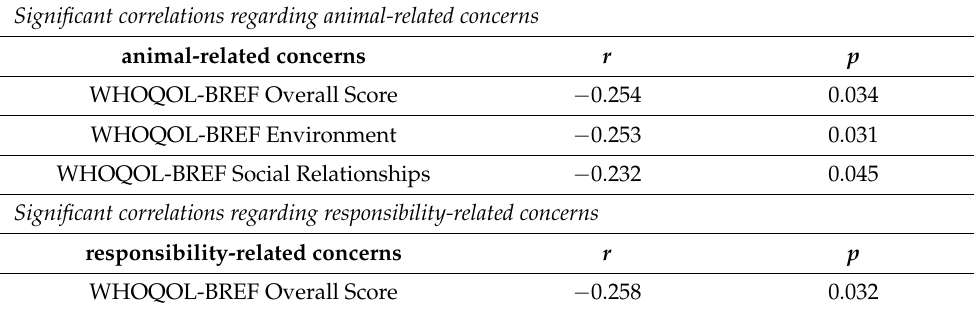
Table 5. Significant correlations regarding pet-related concerns “Long